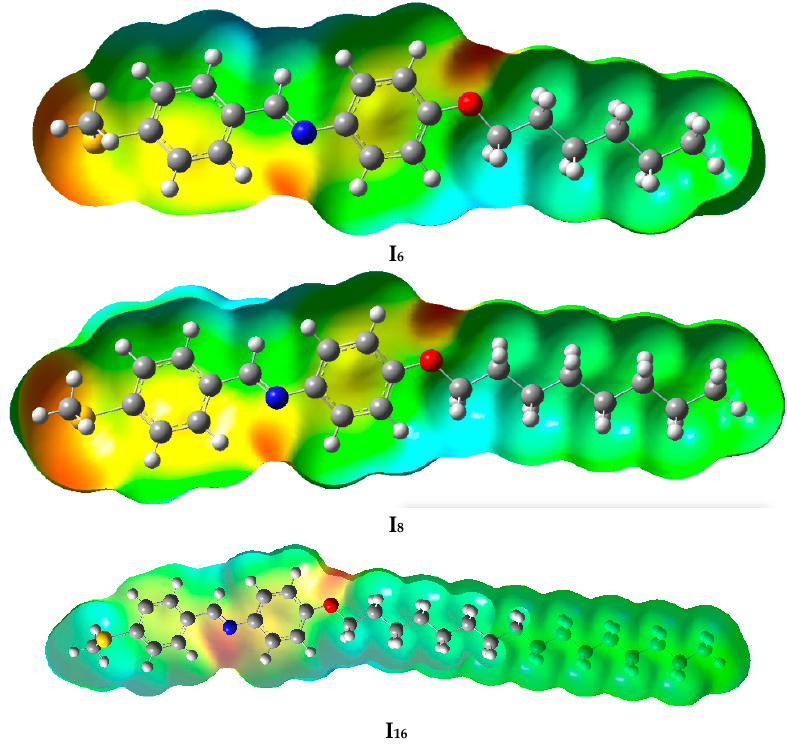
Figure 8. The molecular electrostatic potentials of the prepared I